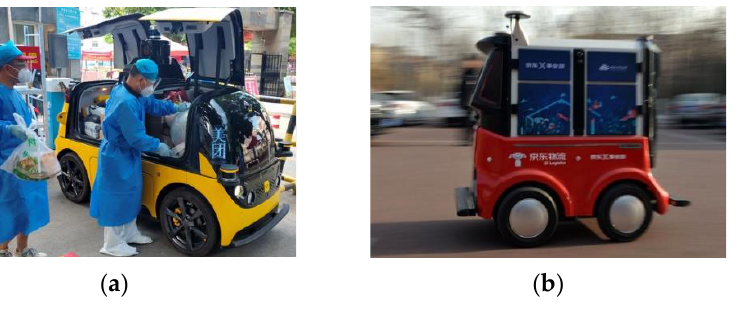
Figure 1. Unmanned delivery robots enable fast, efficient, and contactless delivery services. ( a ) Meituan delivery robots deliver living supplies to epidemic-stricken areas; ( b ) JD delivery robot cargo transportation test; ( c ) UISEE delivery robot enables unmanned delivery service at KAUST.